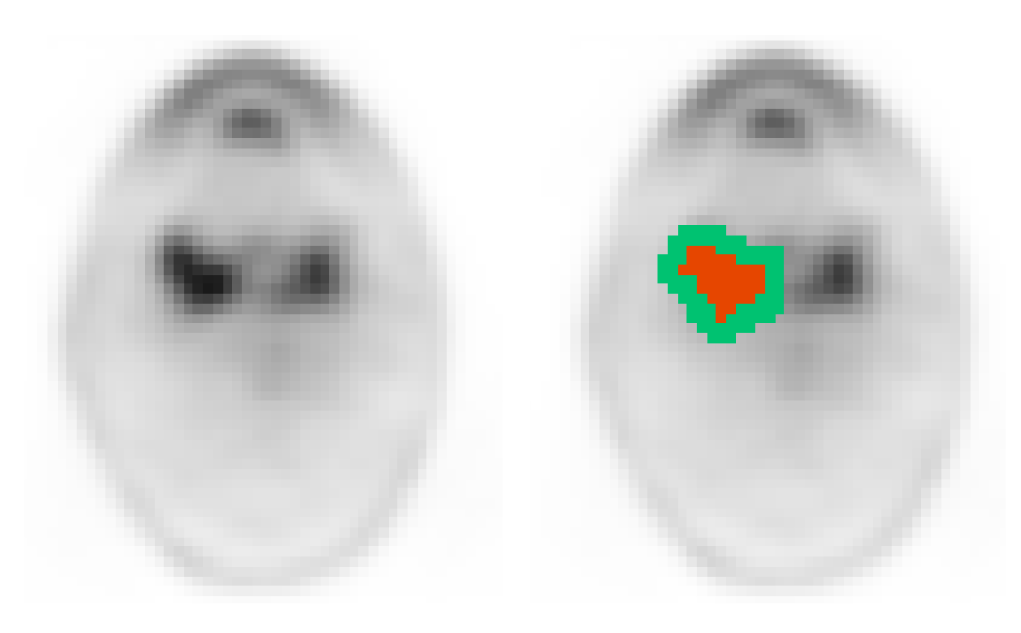
Fig 1. Example of a rim region (green mask) used for calculating feature RA relative to the lesion segmentation (red mask).